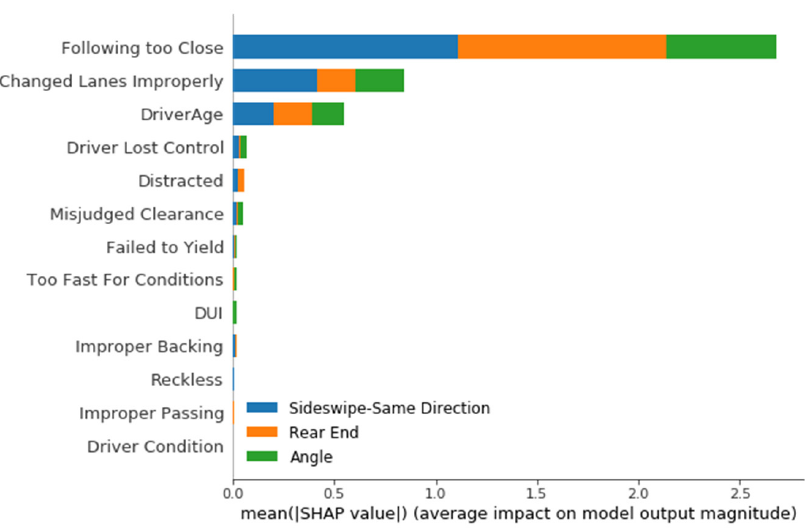
Figure 11. Influence of driver-related features on crash types.